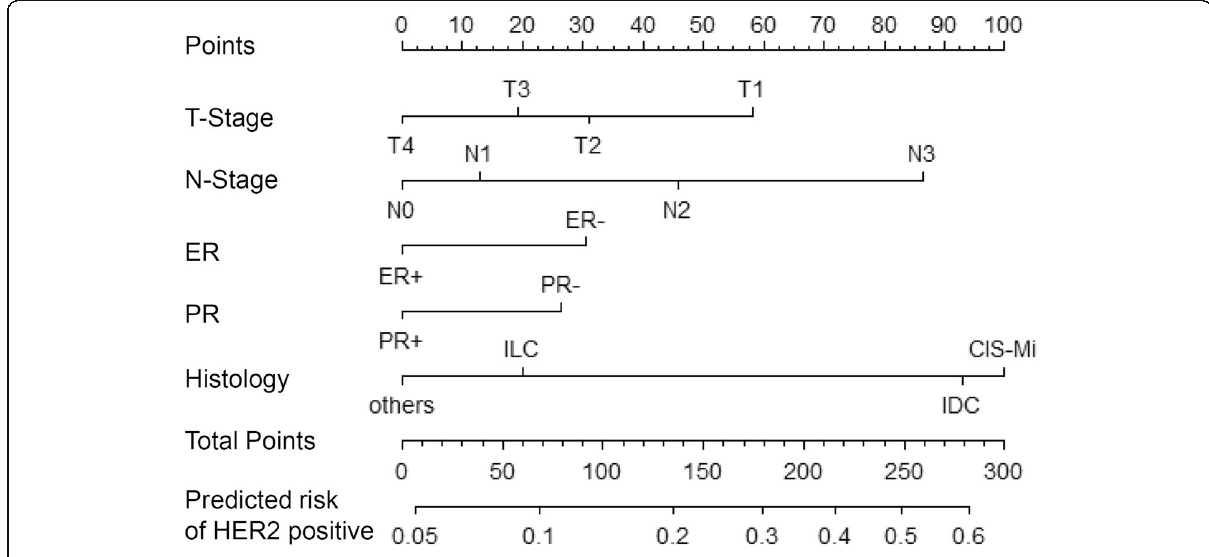
Fig. 2 A nomogram to predict the probability of HER2 positive breast